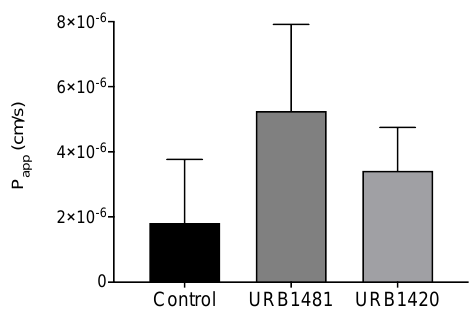
Figure 5. The apparent permeability coefficient of FITC-Dextran in the presence of URB1481 and URB1420 at a concentration of 4 mM across Calu-3 monolayers. The values reported are the mean ± SD of three independent experiments. * p < 0.05 vs. control (Student’s t -test).